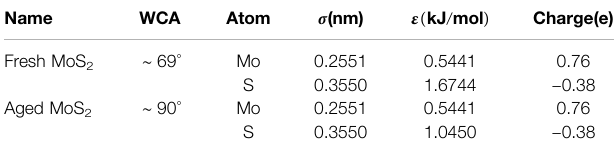
TABLE 1 | Experimentally determined WCAs (Kozbial et al., 2015) and the resultant energy parameters from theoretical calculations (Luan and Zhou 2016;Zhanget al.,2019)for thefreshand agedMoS 2 nanosheets, respectively. σ and &epsi; are the parameters for the vdW interactions in a CHARMM-like